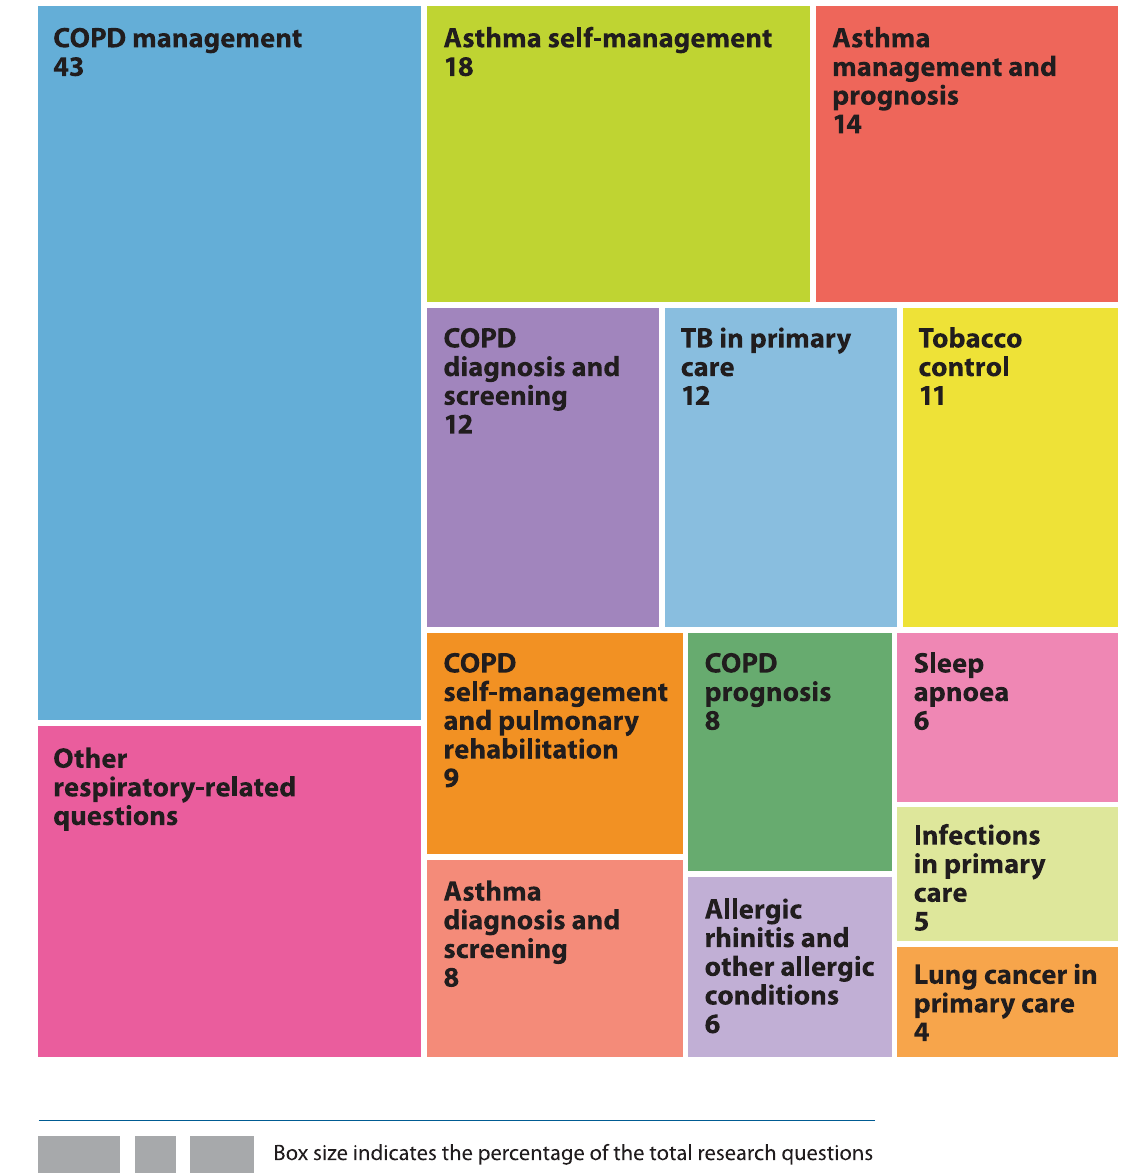
Fig. 3 Proportional distribution of fi nal research questions across the 14 topics after the Evidence Veri fi cation